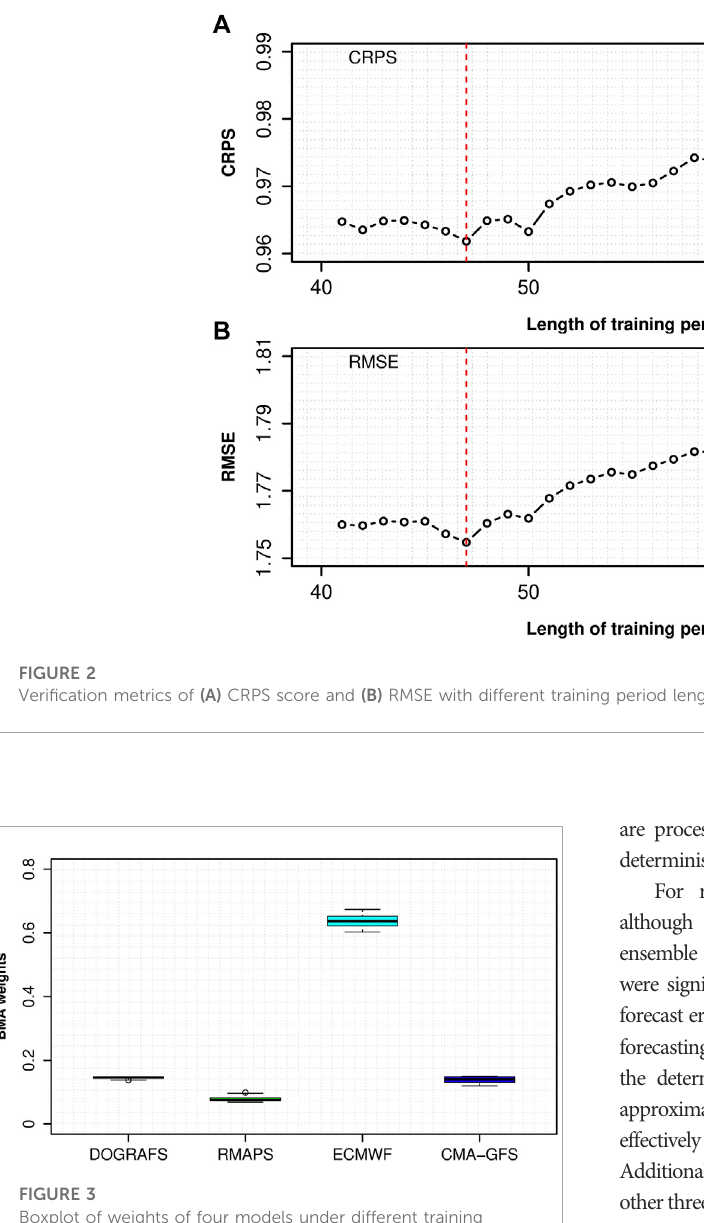
FIGURE 3 Boxplot of weights of four models under different training periods for the BMA